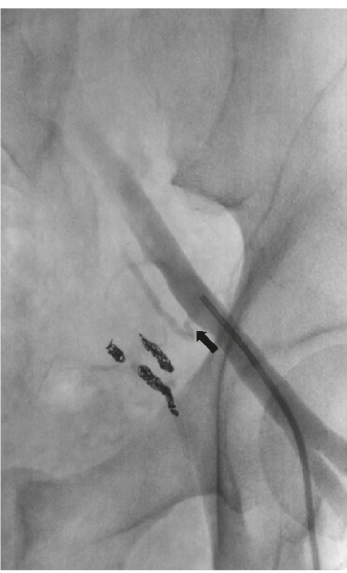
Figure 4: Left common iliac injection. The inferior epigastric artery is clearly seen (arrow). Note absence of a corona mortis or pubic branches originating from the left inferior epigastric